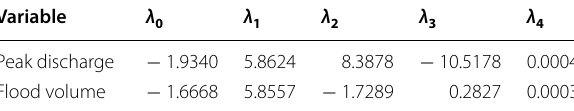
Table 7 Lagrange multipliers for POME-based univariate distribution